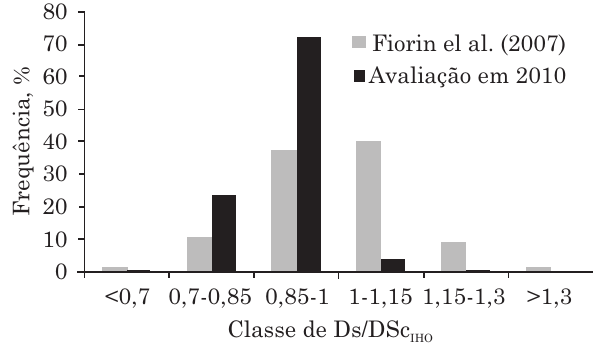
Figura 3. Razão Ds/Dsc IHO [1.884 dados de 32 municípios do oeste do Rio Grande do Sul publicados por Fiorin et al. (2007) e 648 dados cedidos pelo doutorando Marcelo Mentges]. A densidade crítica (Dsc IHO ) foi calculada pela equação Dsc IHO = 1,83803 - 0,00078* Argila (Reichert et al.,